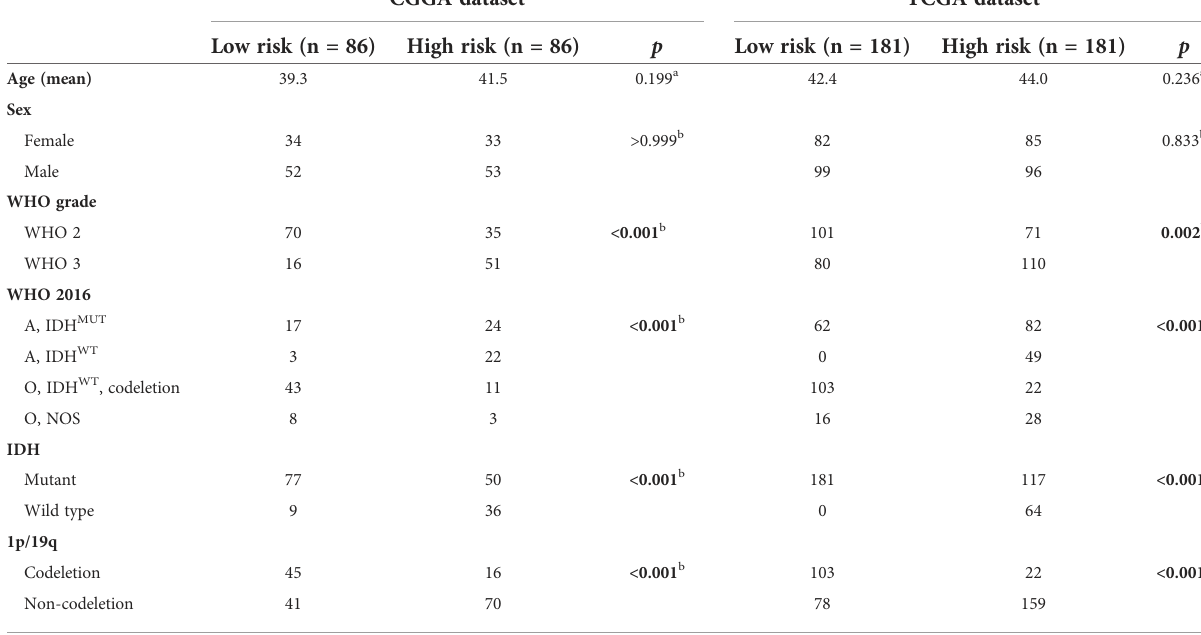
TABLE 2 Clinical characteristics of LGG patients in CGGA and TCGA